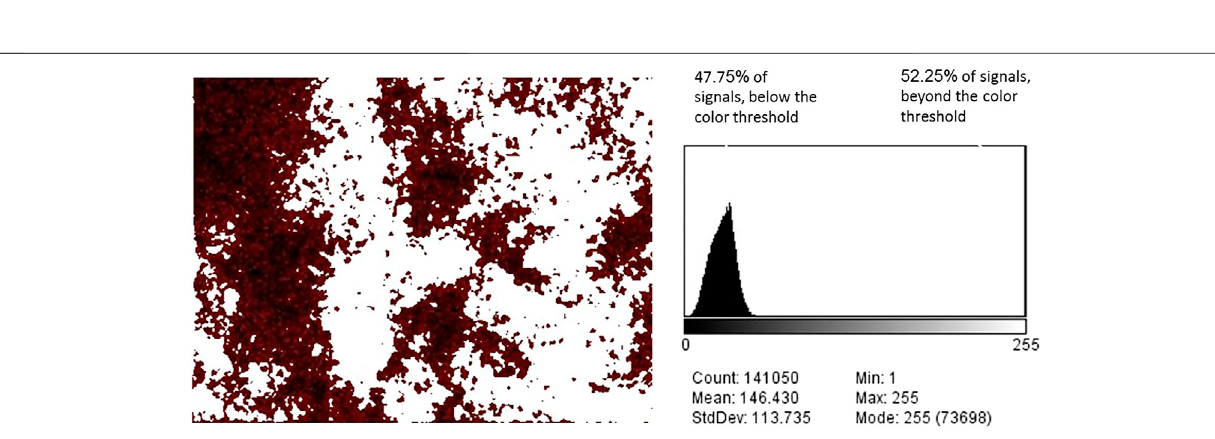
Frontiers in Environmental Chemistry |